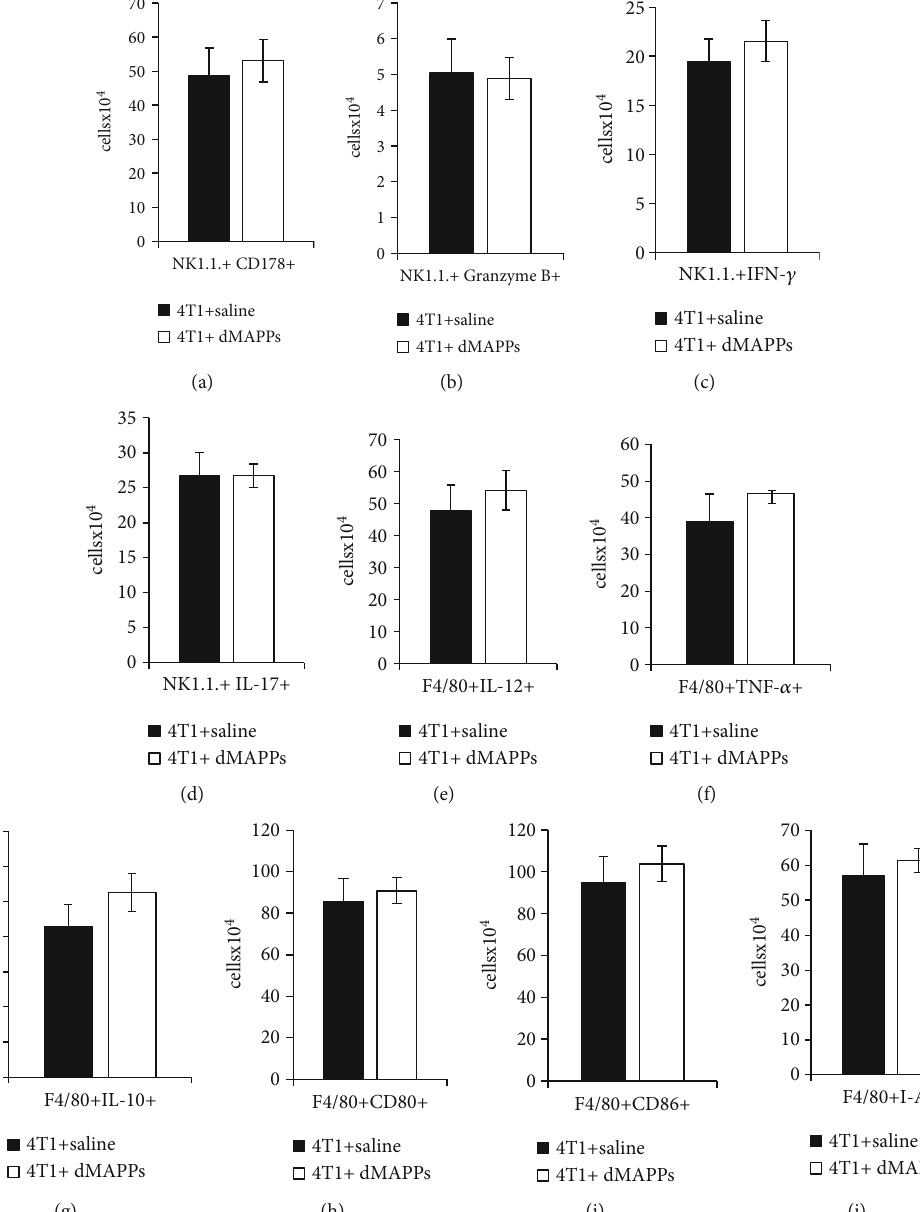
Figure 3: d-MAPPS did not signi fi cantly alter phenotype and function of tumor-in fi ltrated NK cells and macrophages. Flow cytometry analysis and intracellular staining of (a) tumor-in fi ltrated CD178+, (b) granzyme B+, (c) IFN- γ +, IL-17+ NK1.1+NK cells and (e) IL- 12+, (f) TNF- α +, (g) IL-10+, (h) CD80+, (i) CD86+, and (j) I-A+ F4/80+ macrophages in the tumors of 4T1+saline-treated (black bars) and 4T1+d-MAPPS-treated mice (white bars). Data are presented as mean + / − SEM ( n = 16